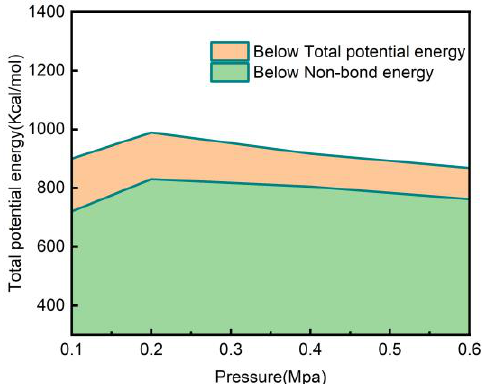
Figure 4. Total potential energy and nonbonding energy under different pressure models . Table 1. Mean value of bond energy for different pressure models. Table 1. Mean value of bond energy for different pressure models. Pressure